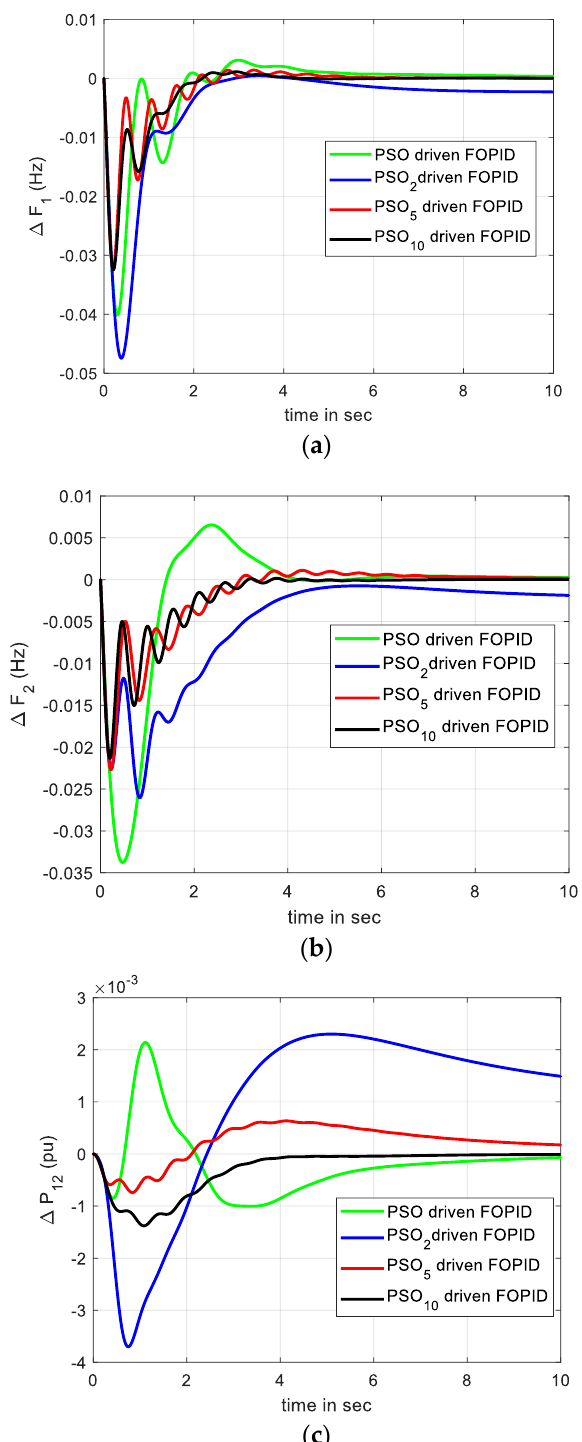
Figure 8. Dynamic responses for case study-I: ( a ) Δ𝐹 1 , ( b ) Δ𝐹 2 , and ( c ) Δ𝑃 12 . Table 5. Optimally tuned parameters of FOPID controllers with different optimisation techniques for case study-II.